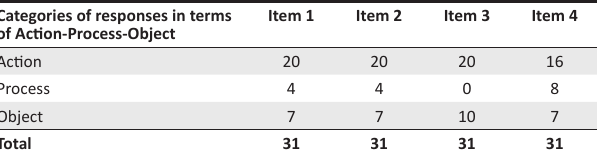
TABLE 4: Students’ performances in semester 1. Categories of responses in terms of Action-Process-Object